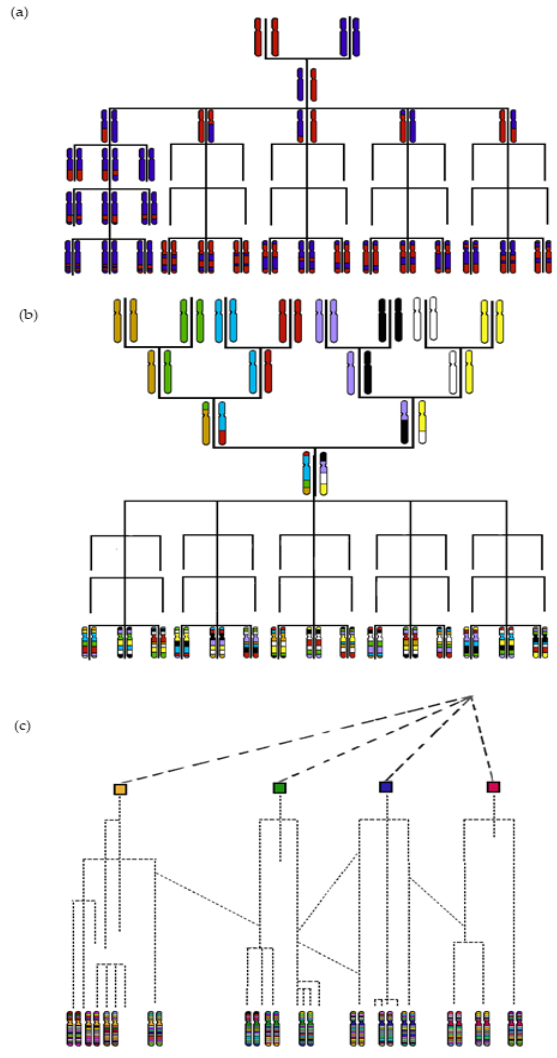
Figure 1. Linkage disequilibrium (LD) bloc exchanges among generations in different populations ( a ) Recombinant inbred line population. The allelic diversity studied is limited to the genetic variation between the two parents. LD bloc extents decrease with the number of generation. ( b ) Multi-parent advanced generation inter cross (MAGIC) population, contrasted parents are crossed to obtain heterozygous individuals, which are thus selfed by single seed descenton several generations to obtain the MAGIC population. The allelic diversity is limited to the initial parents. ( c ) Diversity panel, allelic diversity, and mapping precision result from the history of the species. Here, we illustrated the case of a population resulting from four fictitious ancestors.